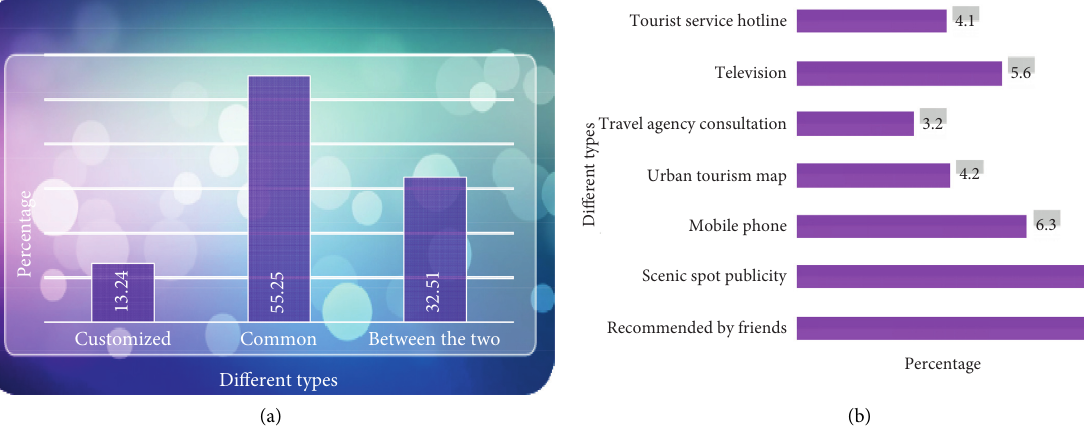
Figure 5: (a) Universality analysis of tourists’ demand for tourism information services and (b) ranking of importance of tourism in- formation service channels.